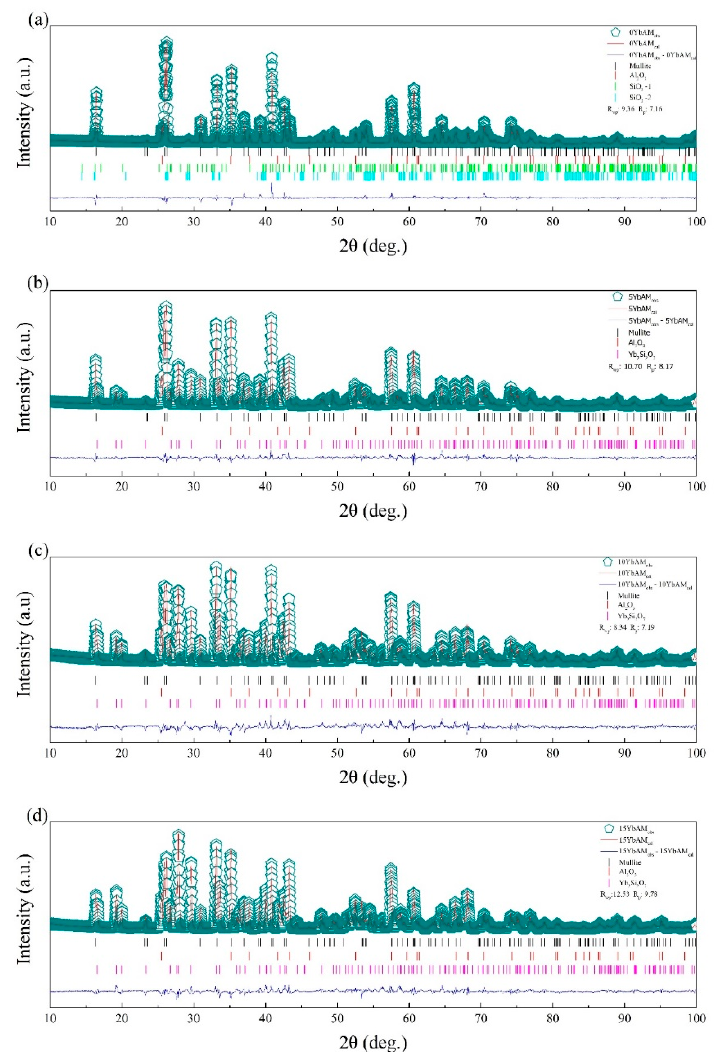
Figure 2. Refined XRD patterns of ( a ) mullite, ( b ) 5YbAM, ( c ) 10YbAM, and ( d ) 15YbAM.